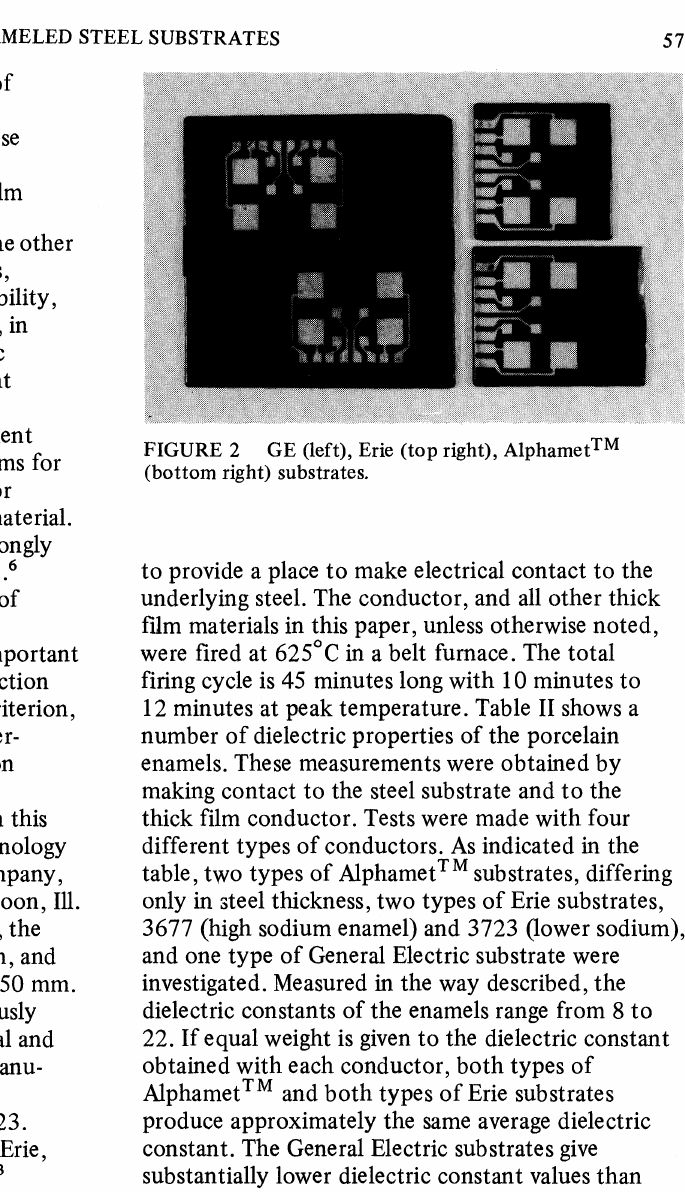
FIGURE 2 GE (left), Erie (top right), Alphamet TM (bottom right)